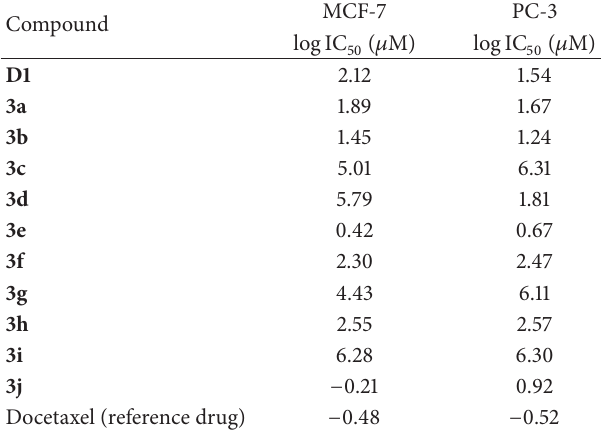
Table 1: Evaluation of the cytotoxicity and log IC 50 values ( 𝜇 M) of chalcone compounds and docetaxel (reference chemotherapeutic drug) of two cancer cell lines. log IC 50 is the concentration of drug that reduces cell growth by